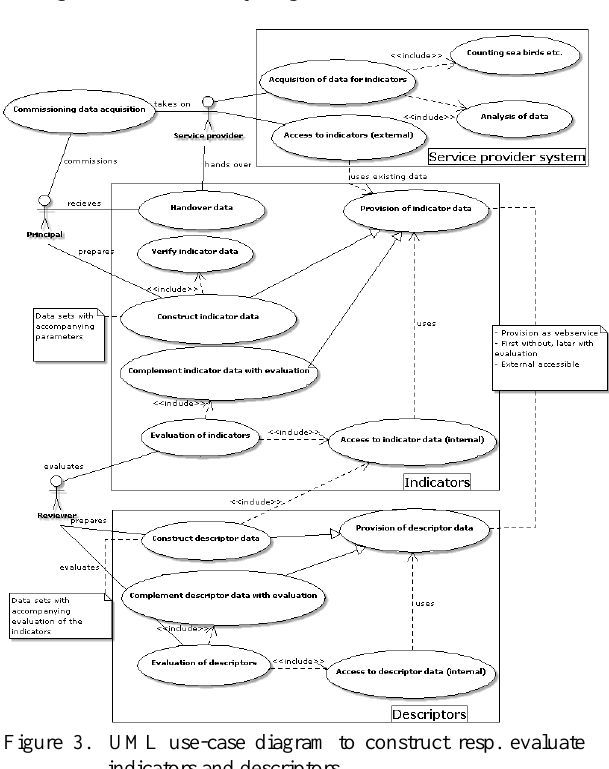
Figure 3. UML use-case diagram to construct resp.